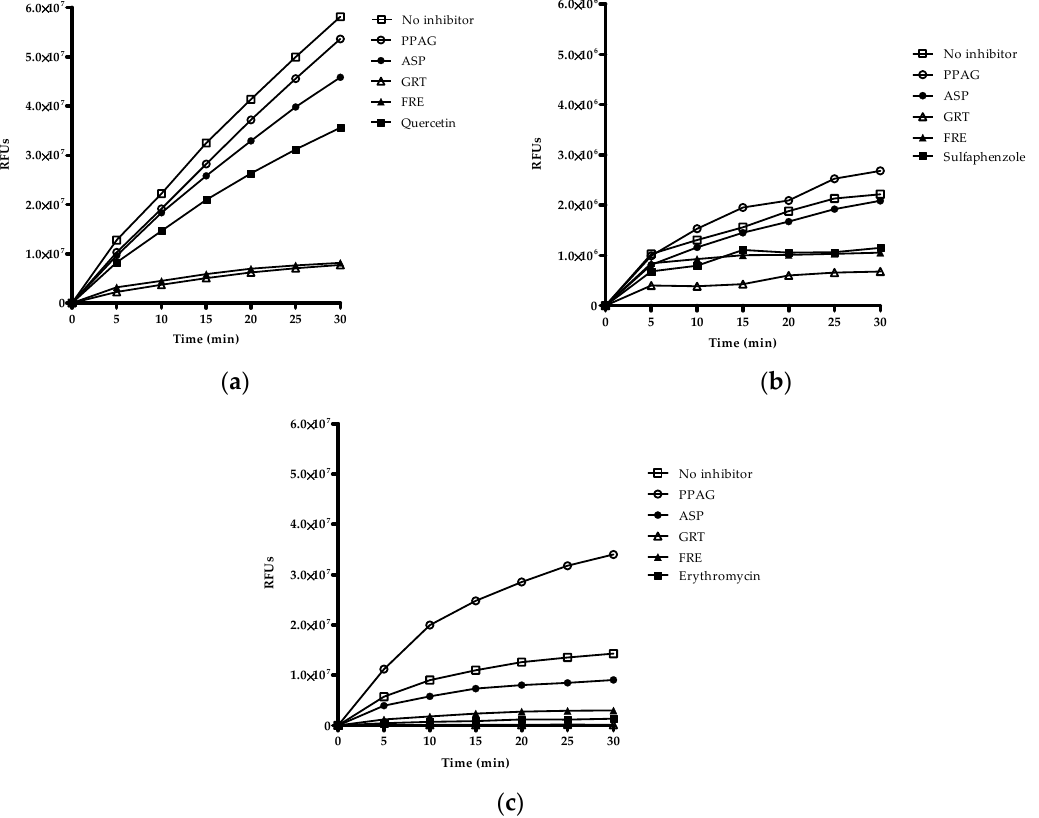
Figure 5. Screening of PPAG ( Z -2-( β - D -glucopyranosyloxy)-3-phenylpropenoic acid), ASP (aspalathin), GRT (unfermented rooibos extract), and FRE (fermented rooibos extract) based on time-dependent inhibition of ( a ) CYP2C8 and ( b ) CYP2C9 at 100 µg/mL, and ( c ) CYP3A4 at 200 µg/mL, respectively, in the presence of NADPH for 30 min with subsequent addition of substrate. Quercetin, sulfaphenazole, and erythromycin at 10 µM were included as positive inhibitors. Data are presented as relative fluorescence units (RFU) for two independent assays done in duplicate ( n = 4).